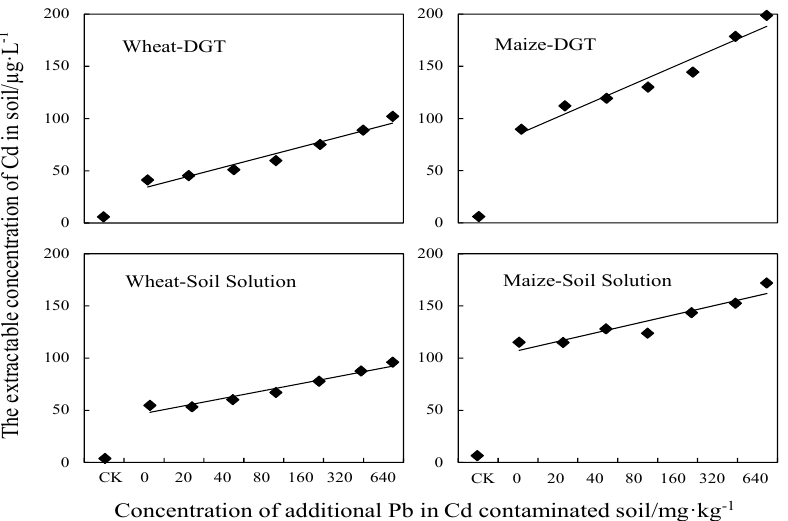
Figure 3. Bioavailable Cd by DGT and Soil Solution in wheat/maize-grown soils. CK represents the control group.